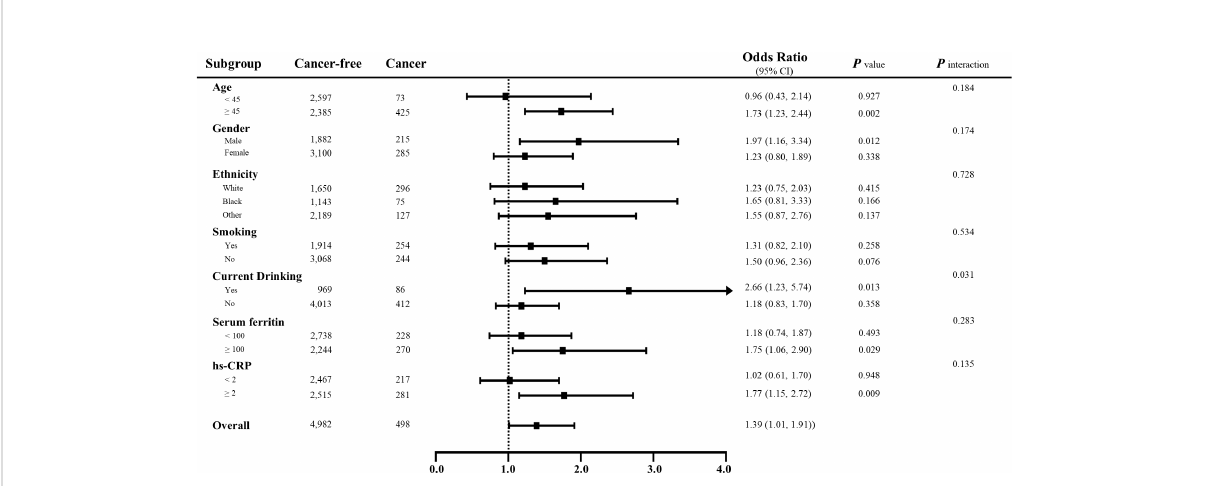
FIGURE 4 Subgroup analyses for the associations between sTfR and the prevalence of total cancers strati fi ed by participant characteristics. Results are expressed as multivariable-adjusted odds ratio in continuous analyses after controlling covariates including age, gender, ethnicity, body mass index, family income, education, smoking, drinking, diabetes, hypertension, cardiovascular diseases, systolic/diastolic blood pressure, serum iron, ferritin, total protein, total cholesterol, high-density lipoprotein cholesterol, hemoglobin, HbA1c, hs-CRP, systemic immune-in fl ammation index and nutrition intake, where possible interactions between above factors are also adjusted if necessary. In the continuous analyses, the value of variables was ln-transformed.